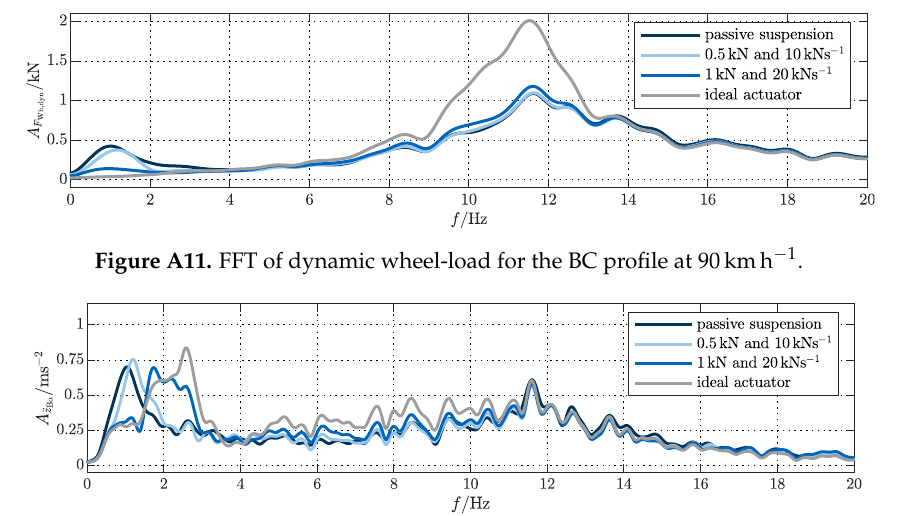
Figure A12. FFT of body acceleration for the BC profile at 90kmh − 1 with the objective of minimizing dynamic wheel-load variation.